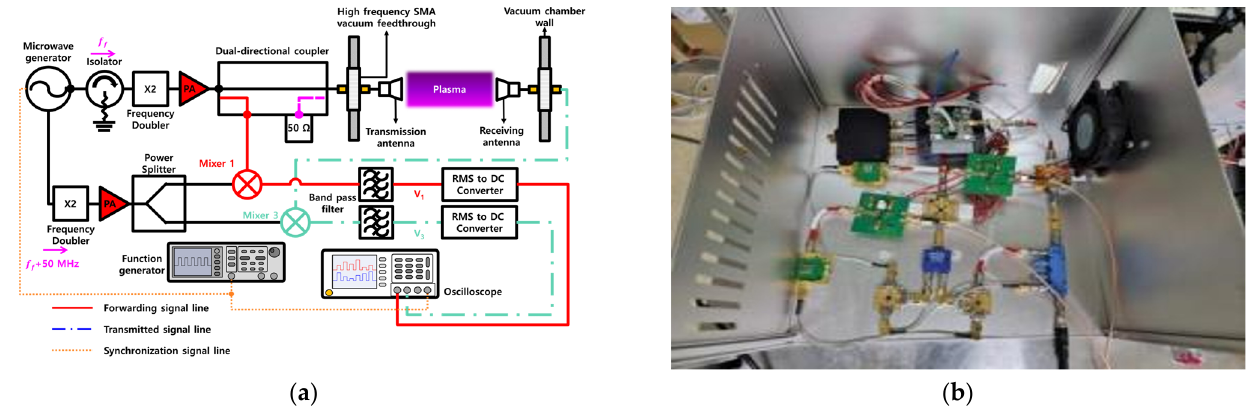
Figure 2. Reflectometry circuit construction; ( a ) diagram of reflectometry circuit, ( b ) photograph of reflectometry circuit.